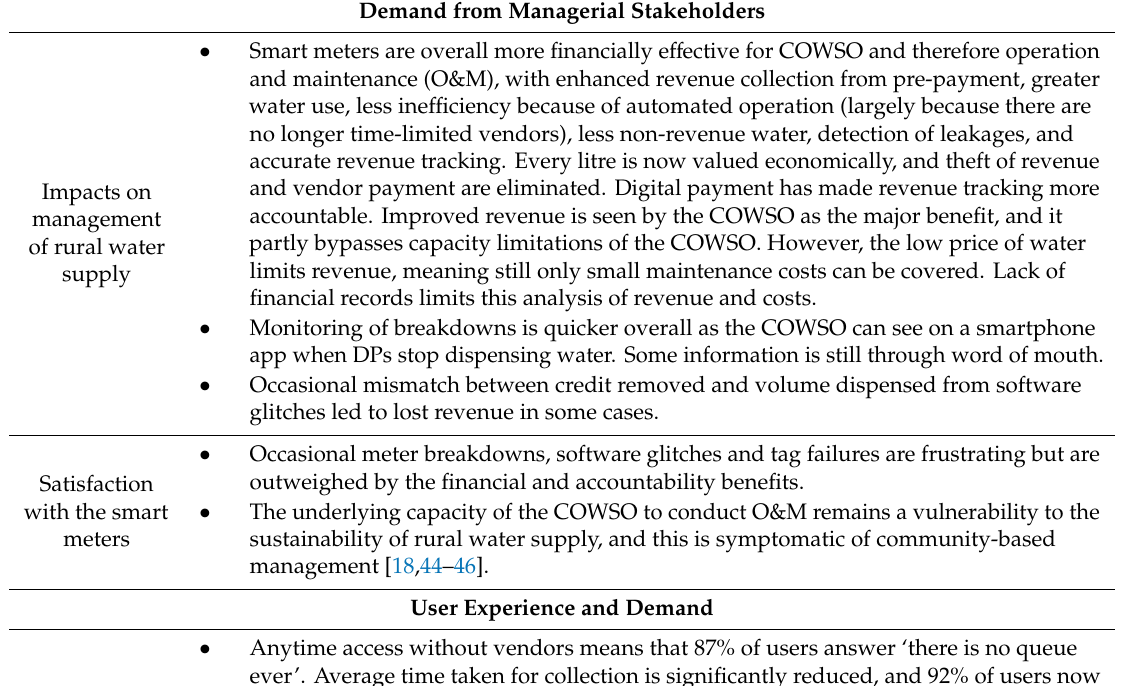
Table 1. Major findings of the broader evaluation of smart meters in Community A Demand from Managerial